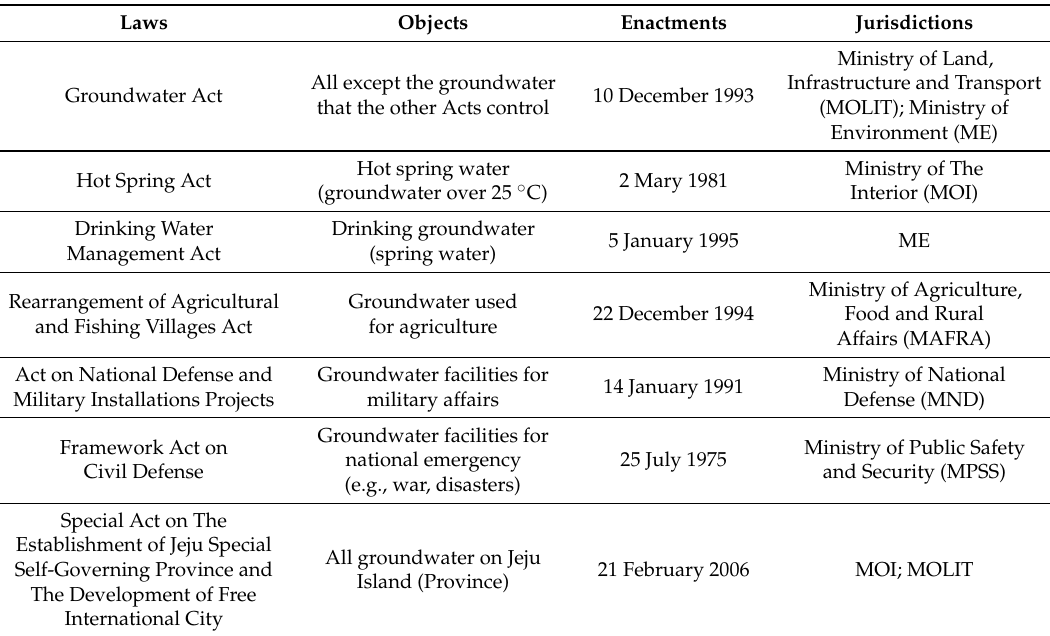
Table 1. Groundwater related laws and regulations in